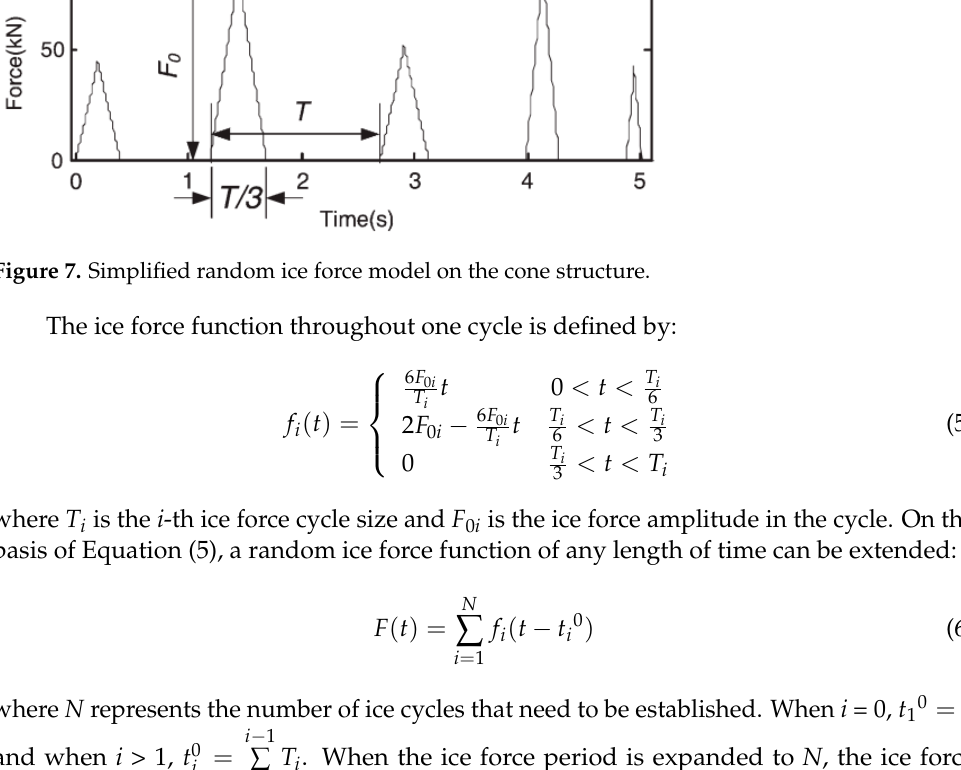
= 0 where N represents the number of ice cycles that need to be established. When i = 0, t 10 = 0 and when i > 1, 1 i − 1 ∑ = T i . When the ice force period is expanded to N , the ice force amplitude is F 0 i for each period, and the ice force period T i constitutes two random series. To obtain a random ice force function that can be applied, it is necessary to calculate the ice force period and ice force amplitude of the real ice force and determine the random distribution of the ice force period and amplitude sequence used in Equation (1). Based on the measured data of the Bohai platform, the statistical characteristics of the ice force amplitude and ice force period of the cone ice force were analyzed. It was found that both the ice force period and the ice force amplitude obeyed normal distributions, as shown in Figures 8 and 9.